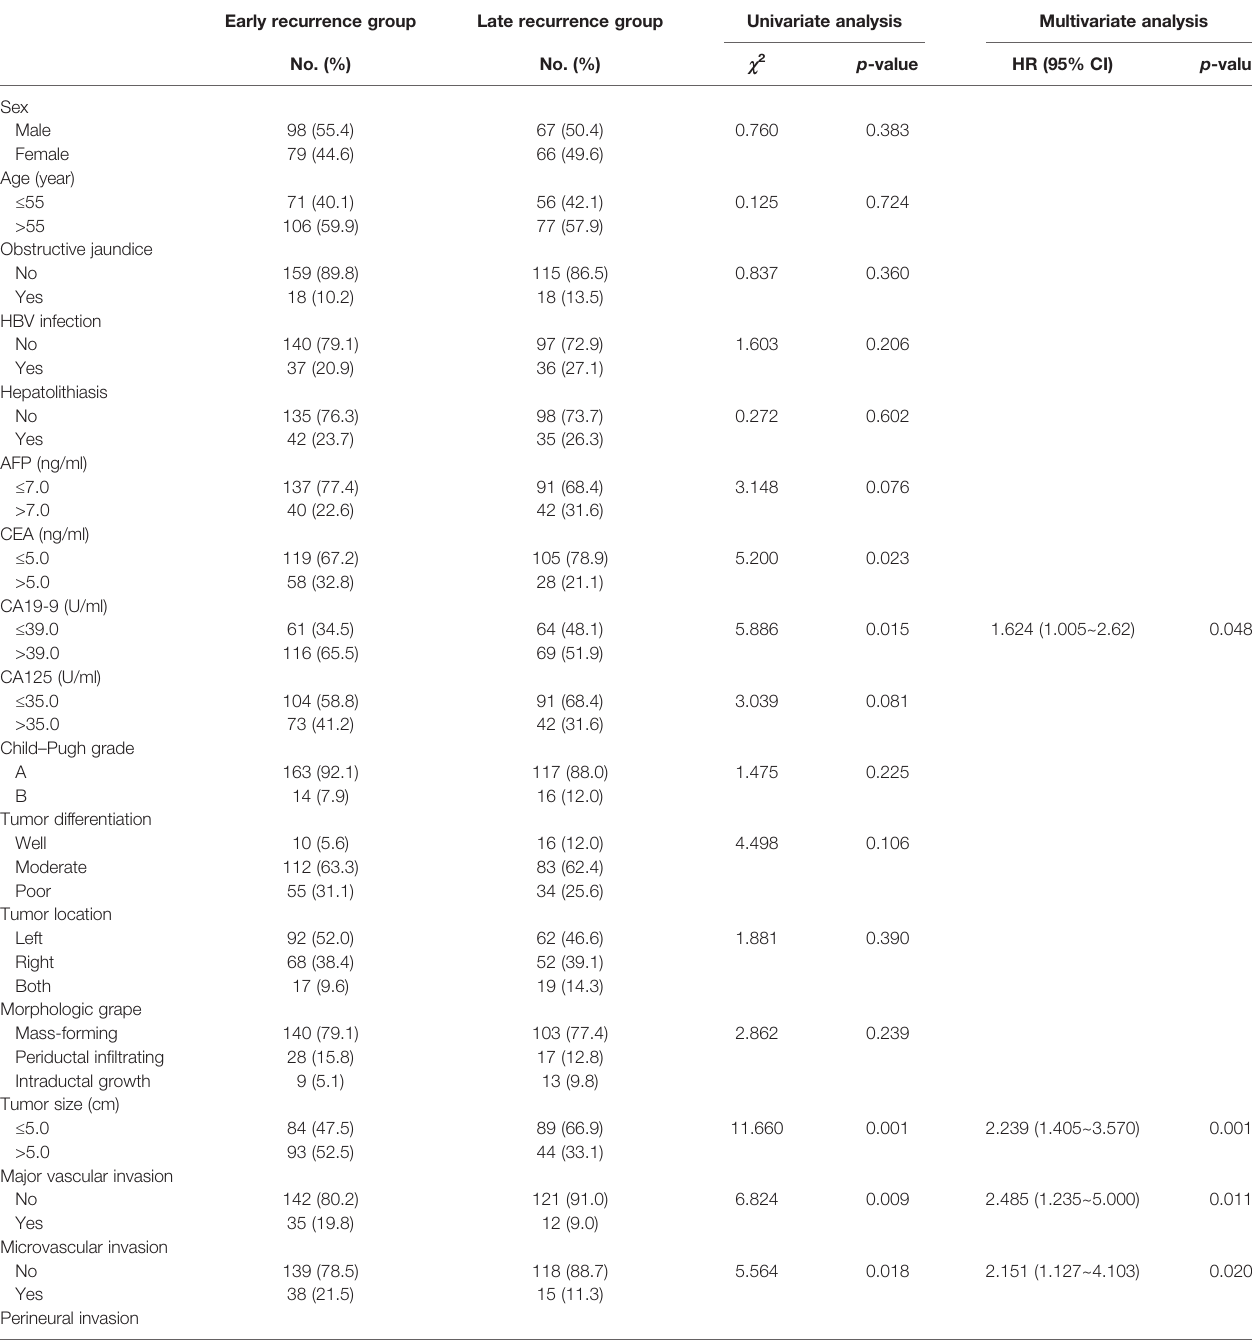
TABLE 2 | Comparison of clinicopathologic characteristics of early recurrence and late recurrence for ICC after radical